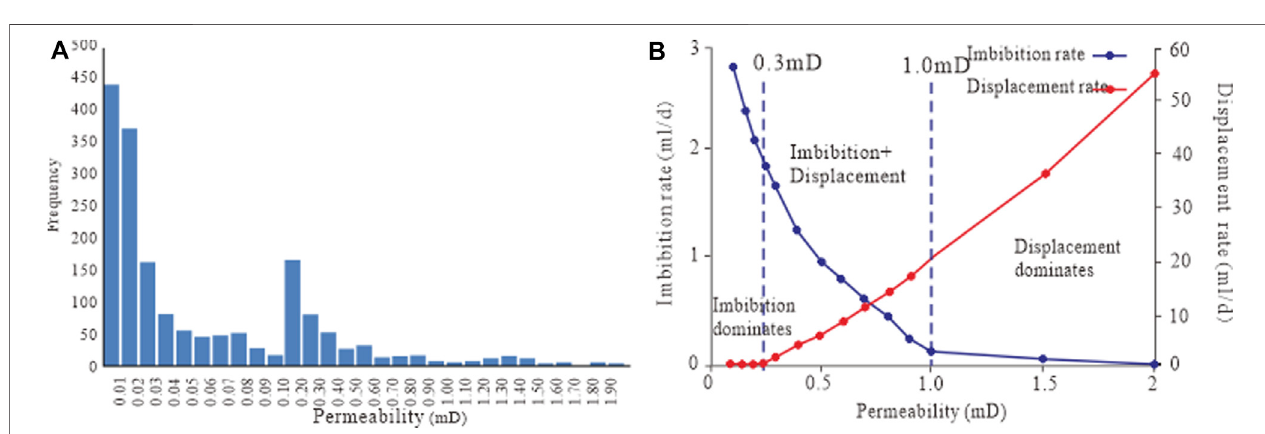
FIGURE 4 | (A) permeability frequency distribution plot of Lucaogou Formation in Jimusar Sag and (B) effect of permeability on imbibition and displacement (modi fi ed after Wang (2019)).